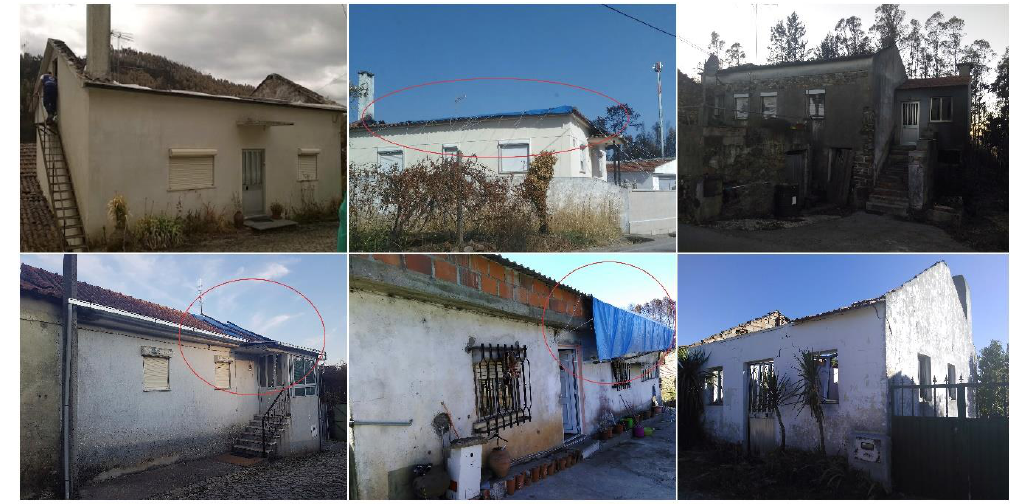
Figure 7. Example of houses that had ignitions through the roof.